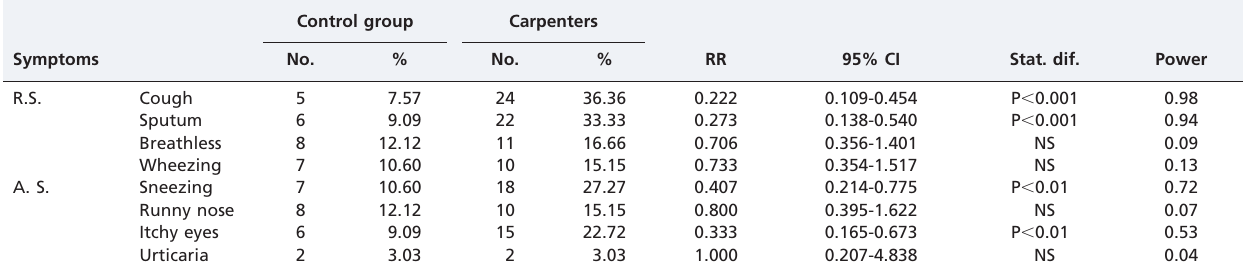
Table 2 - Comparison of respiratory and allergic symptoms between control group and carpenters. Control group Carpenters